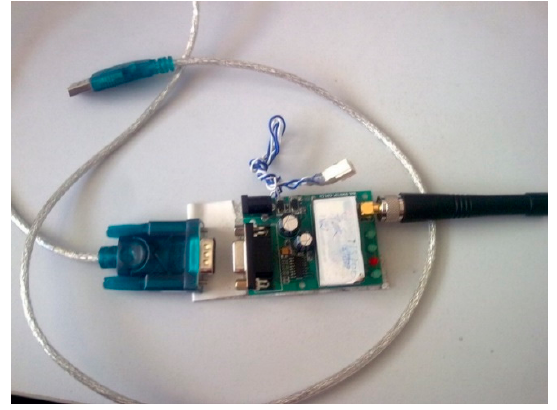
Figure 7. Wireless communication module and computer connection.